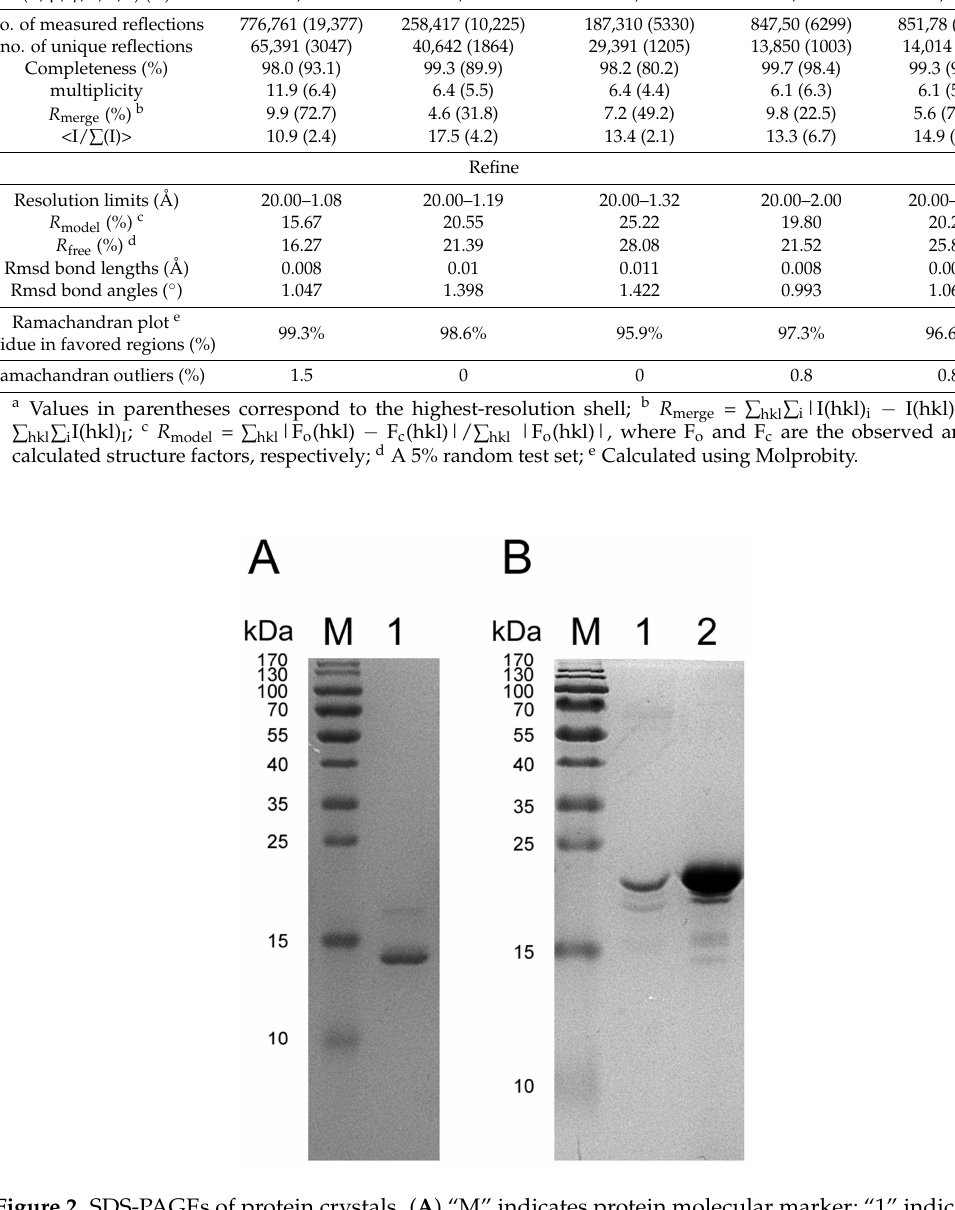
Figure 2. SDS-PAGEs of protein crystals. ( A ) “M” indicates protein molecular marker; “1” indicates the crystallized protein in the first crystallization condition containing 20% ( w / v ) PEG2000 MME. The molecular weight of this protein is approximately 14 kDa; ( B ) “M” indicates protein molecular marker; “1” indicates the crystallized protein in the second crystallization condition containing 0.1 M Tris pH 8.5, 0.01 M NiCl 2 , 20% ( w / v ) PEG2000 MME; “2” indicates the protein after his-tag cut off. The protein bands in “1” and ”2” are same that means Gal-8 N-terminal CRD with the linker was crystallized.